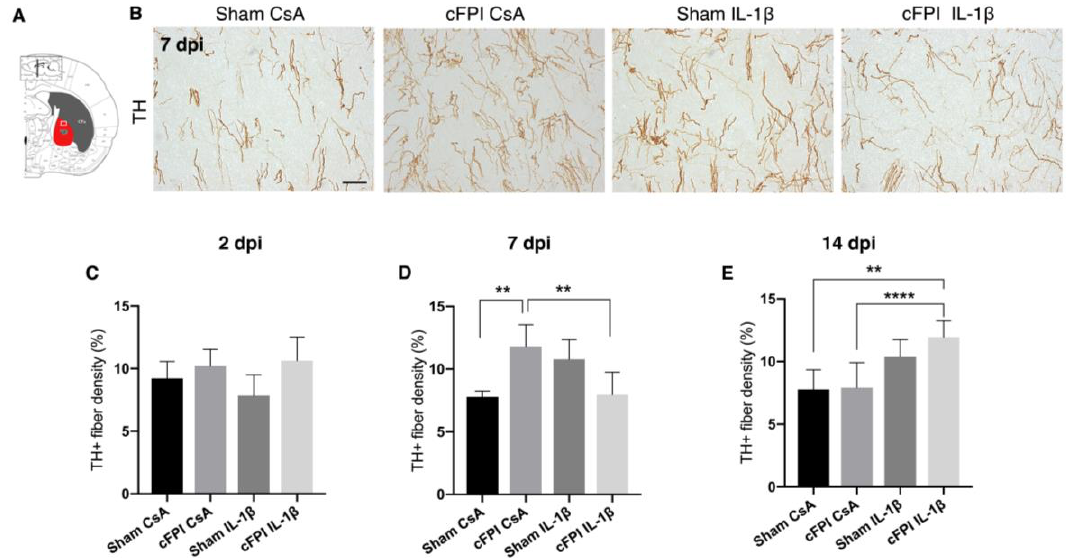
Figure 3. Effects of diffuse traumatic brain injury and neutralizing IL-1β antibody on tyrosine hydroxylase-positive axon density in the globus pallidus. ( A ) Schematic representation of a coronal brain section showing location of globus pallidus (GP) and GPe (framed area in ( A )). ( B ) Representative images showing TH+ axons in the GP at seven dpi, scale bar 20 μm. ( C ) Compared with control-treated, sham-injured (sham CsA) animals at two dpi, there was no change in the density of TH+ axons (sham CsA, n = 4; sham IL-1β, n = 3; cFPI CsA, n = 6; cFPI IL-1β, n = 6) ( D ) At seven dpi, the density of TH+ axons were increased significantly in the control-treated, brain-injured (cFPI CsA) animals in comparison to sham CsA (sham CsA, n = 4; sham IL-1β, n = 3; cFPI CsA, n = 7; cFPI IL-1β, n = 6; ** p ≤ 0.01). TH+ axon density was attenuated in brain-injured animals treated with the IL-1B neutralizing antibody. (cFPI IL-1β; ** p ≤ 0.01). ( E ) At 14 dpi, no difference was observed in the density of TH+ axons in the cFPI CsA animals in comparison to sham CsA animals. The density of TH+ axons was significantly increased by IL-1β neutralization in the brain-injured mice as compared to Sham CsA and cFPI CsA groups (sham CsA, n = 3; sham IL-1β, n = 3; cFPI CsA, n = 8; cFPI IL-1β, n = 11); **** p ≤ 0.001). cFPI, central fluid percussion injury; dpi, days post-injury; CsA, inactive control antibody against cyclosporin A; IL-1β, interleukin 1 beta; TH, tyrosine hydroxylase; GP, globus pallidus. 3. Discussion In this study, we used the cFPI model of diffuse TBI in mice and observed microglia activation and neuronal changes in the GP that may contribute to the development of PD-like pathology.